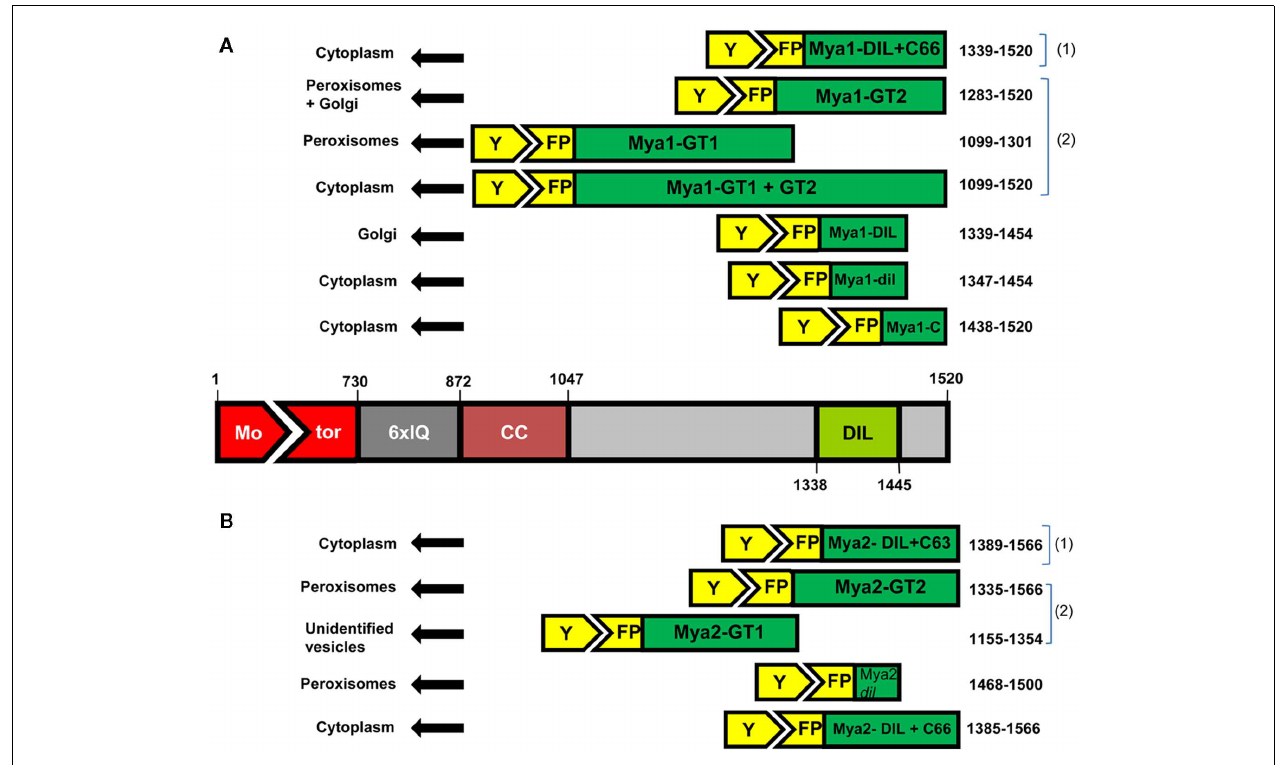
FIGURE 2 |The amino acid positions and lengths of the fragments sub-cloned from theAtMya1 (A) andAtMya2 (B) and subcellular localization after transient expression is shown. (1) are constructs described in Reisen and Hanson (2007) and (2) denotes constructs reported by Li and Nebenfuhr (2007).